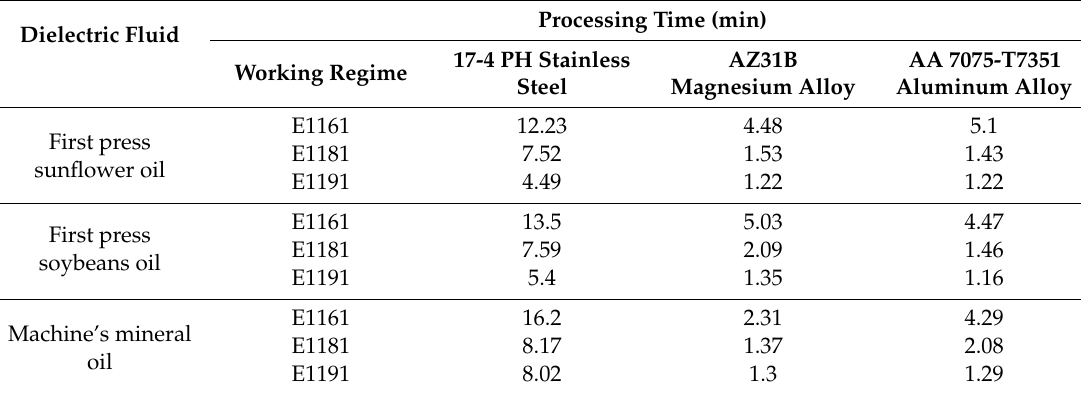
Table 8. Duration for the EDM process for every working